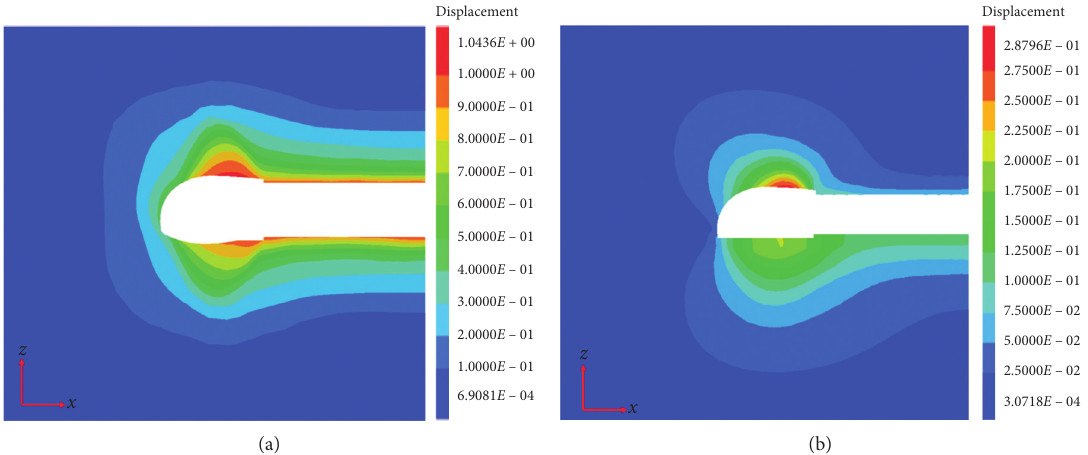
Figure 12: Displacement of surrounding rock (slice plane 2). (a) Without support. (b) Prestressed anchor cable